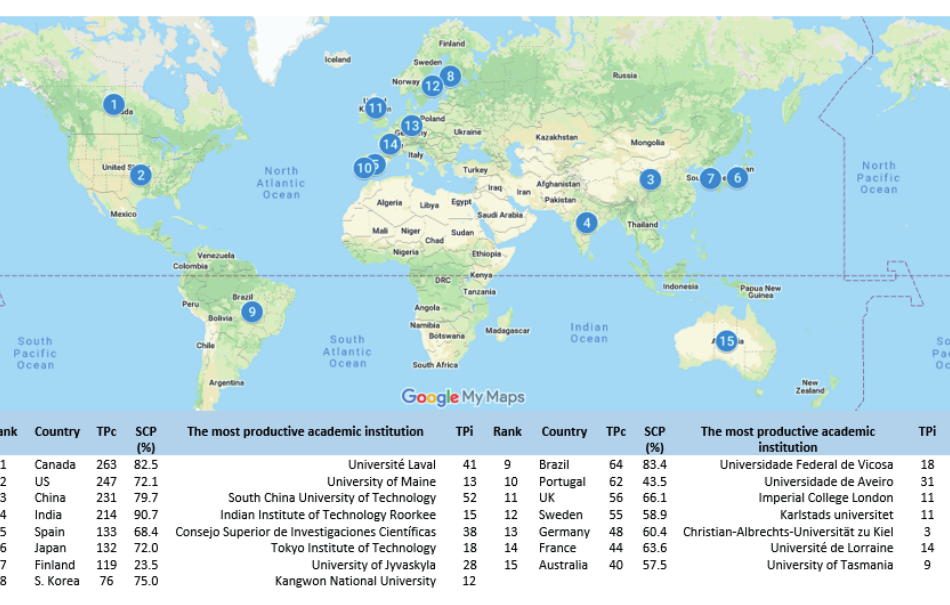
Fig. 3. 15 countries and academic institutions most competitive in paper sludge issuance. TPc: number of publications of a particular country; TPi: the number of publications of a particular academic institution; SCP: single country publication. Number represents the rank of the most productive countries and academic institutions in paper sludge